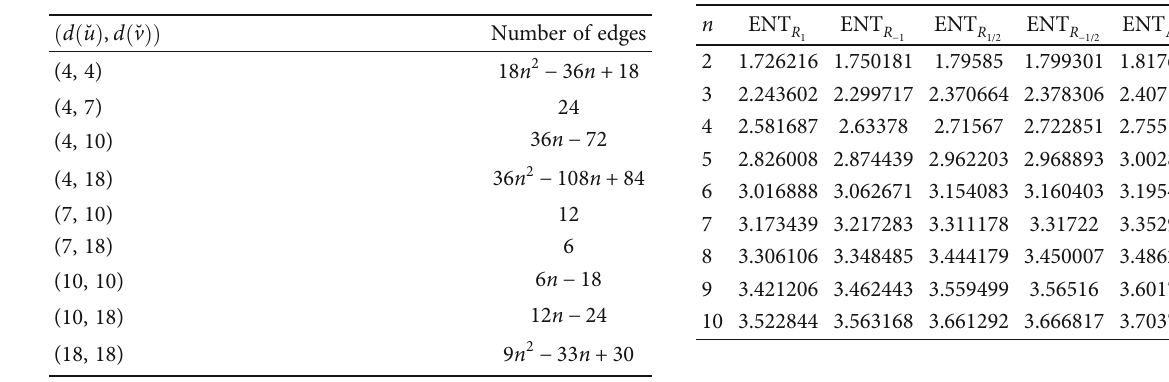
Figure 2: Hex-derived network of third type. Table 1: Edge partition of HDN3 ð n Þ .